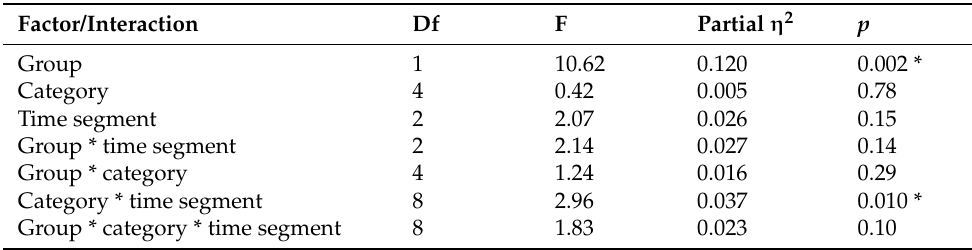
Table 3. Results of the analysis of variance (ANOVA) between picture category, time segment, and group (* significant p values <